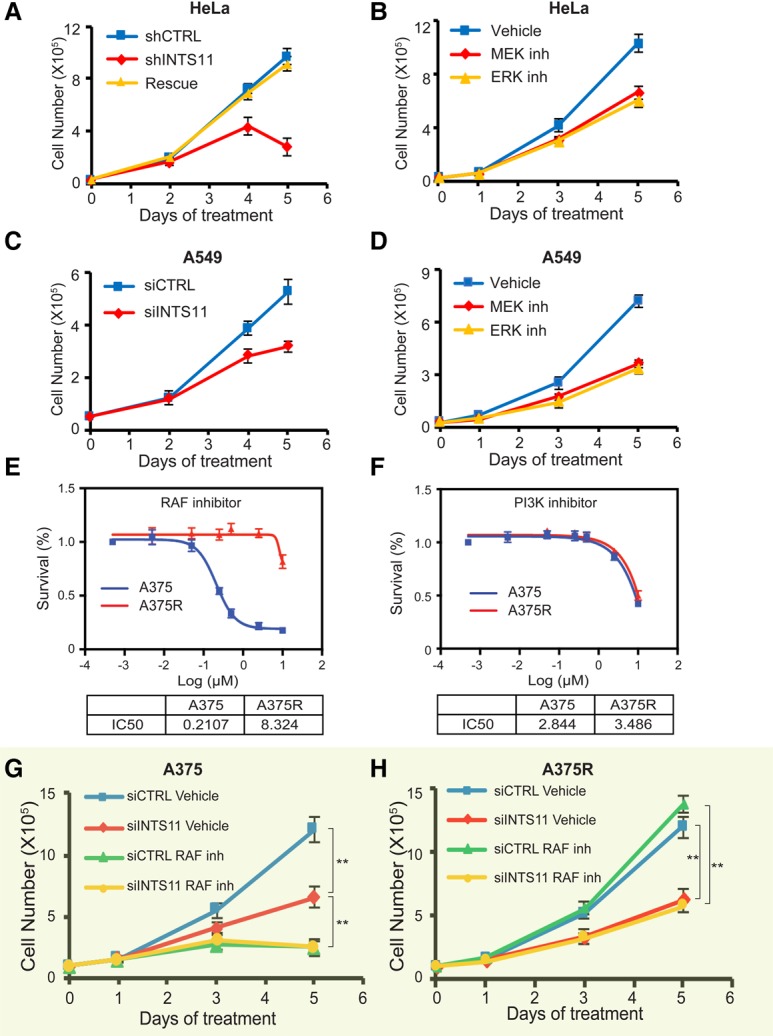
Integrator targeting inhibits growth of cancer cells with MAPK mutations. (A–D) Cell growth curves for HeLa (A,B) or KRAS mutant lung cancer cell A549 (C,D) depleted of INTS11 or treated with MAPK inhibitors. (A) This growth defect was fully rescued by restoring the expression of INTS11 (rescue). (B) Blocking MAPK signaling by treating cells with MEK inhibitor (0.5 µM PD0325901) or ERK inhibitor (1 µM SCH772984) resulted in cell growth inhibition. (C,D) In A549 cells, depletion of INTS11(C) or inhibition of MAPK signaling (D) impaired cell growth. (E,F) IC50s (concentrations of 50% growth inhibition) of RAF inhibitor (vemurafenib; E) and PI3K inhibitor (LY294002; F) for BRAF V600E mutant melanoma cell A375 (E) and RAF inhibitor-resistant line A375R (F) (see the Materials and Methods for details). (G,H) Cell growth curves for A375 (G) and A375R (H) cells. The cells were transfected with nontargeting siRNA (siCTRL) or siRNA against INTS11 (siINTS11) on day 0. Six hours after transfection, the cells were fed with medium containing vehicle or RAF inhibitor (0.4 µM vemurafenib) for up to 5 d. siRNA transfection was repeated on day 2. The average of three independent experiments is shown. (**) P < 0.01.